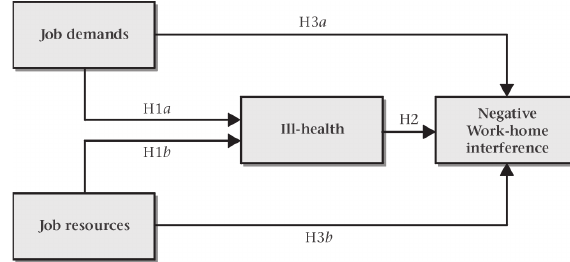
figure 1: Hypothesised model ( Note: numbers